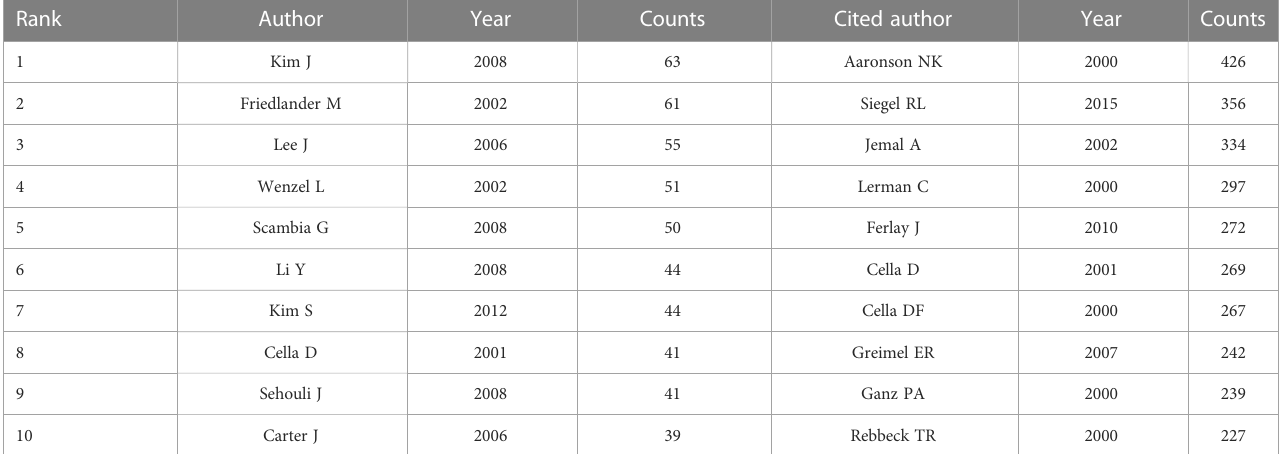
TABLE 5 Top 10 most productive authors and most co-cited